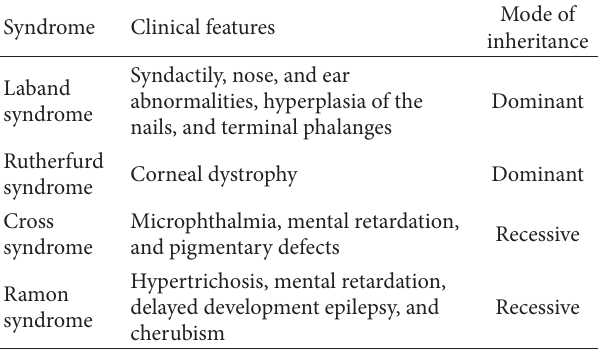
Figure 1: Preoperative photograph with fullness of